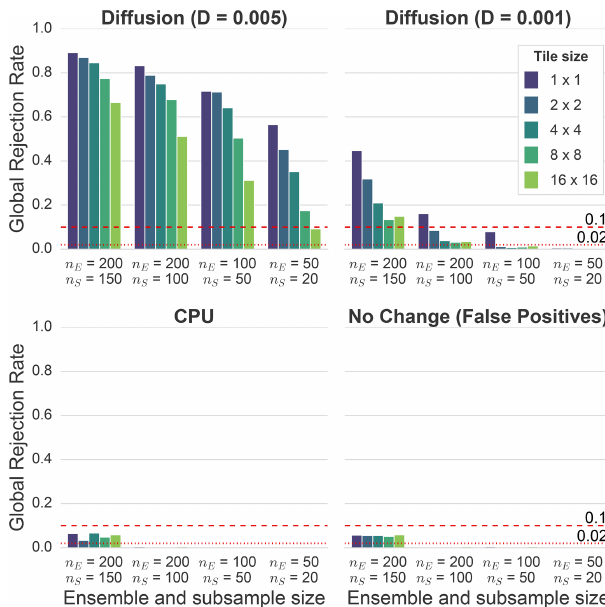
Figure 10. Global rejection rates of the 16 variables during the first 100h, as in Fig. 4, for the diffusion ensemble with D = 0 . 005. A rate of 1.0 would mean that all global decisions would show a re- jection (i.e., only red in Fig. 4). The rates have been calculated for different ensemble and subsample sizes with m = 100 randomly drawn subsamples. They are grouped by tile size, where one tile represents the spatial average value of n × n grid cells. Spatial av- eraging clearly reduces the sensitivity of the test for all ensemble sizes. The red lines indicate thresholds that could be used for an au- tomated testing framework. For example, based on the false positive rate for n E = 200 and n S = 150, one could define a rejection rate of 0.1 as a threshold for this combination of ensemble and subsample sizes (i.e., the model has significantly changed if the rejection rate is greater than 0.1). The threshold should be lower for smaller ensem- ble and subsample sizes (e.g., 0.02 for n E = 200 and n S =